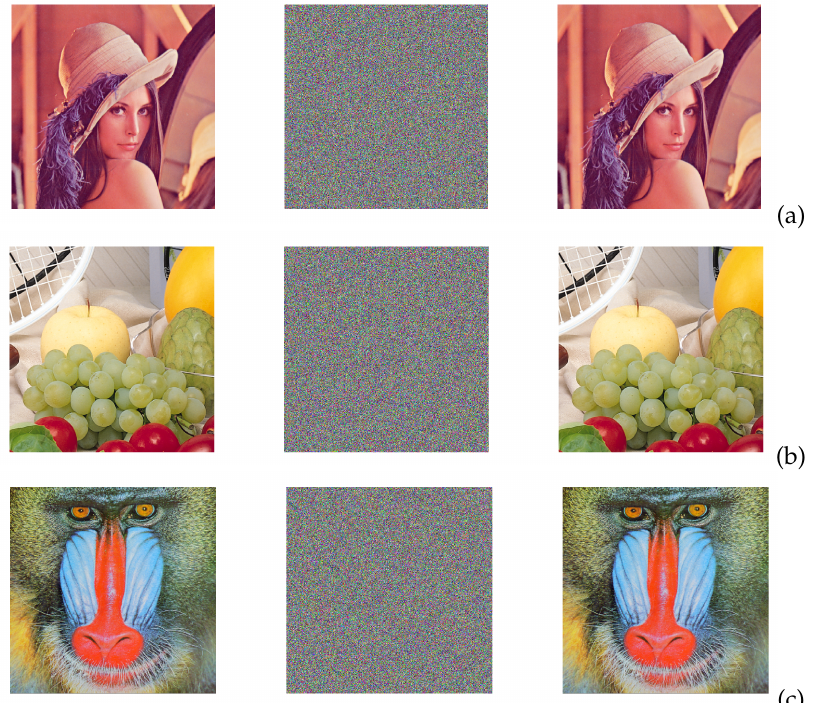
Figure 12. Image encryption using the binary sequences from the FPGA implementation of the Hopfield neuron given in Table 6, and the parameters corresponding to HNNset2. The original image is on the left, the encrypted in the center and the recovered on the right column, for: ( a ) Lena, ( b ) Fruits, and ( c ) Baboon